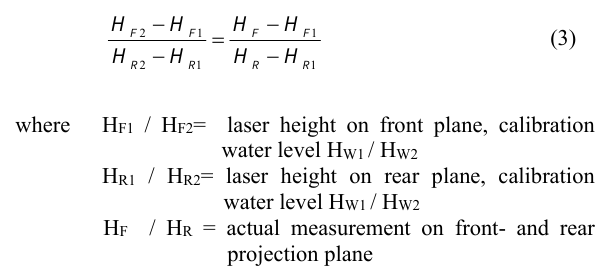
Figure 7: Corresponding laser ends (left: still surface; right: dynamic surface)